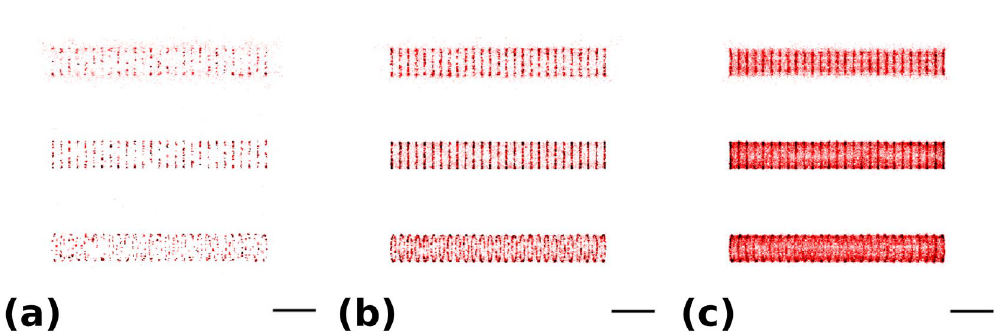
Figure 4. Conventional fluorescent ( a ) and SMLM images with different structured background levels ( b – d ). The higher the background level, the smaller the separation of the adjacent parallel lines. Insets show the separation of the main peaks of the fitted double Gaussian functions. Scale bar is 1 micron.